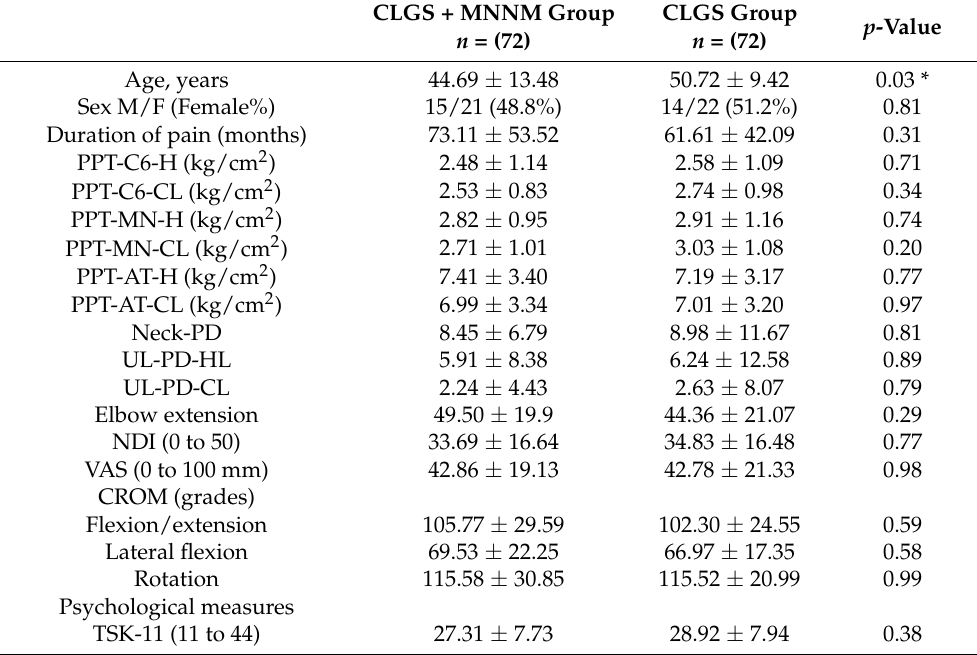
Table 1. Baseline participant characteristics. Values are the mean ± standard